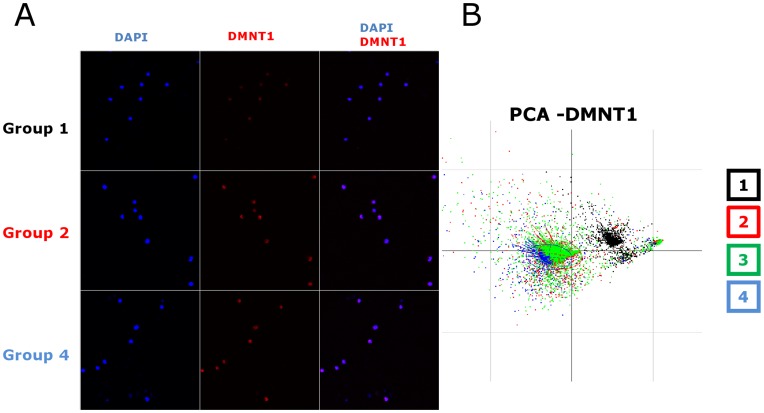
High-content image analysis of the heterogeneous population of DNMT1 immunostained cells of the four groups suggests changes in the cell nucleus.
A. Examples of immunostaining images used for the analysis of DNMT1 expression representative of 9 experiments. The experimental and image analyse procedures were the same as on Figure 3. B. Representative example of the PCA analysis of the data extracted from analysis of the images of DNMT1 immunostained cells. Note that the cluster of cytokine-stimulated and virus-transduced cells overlap.